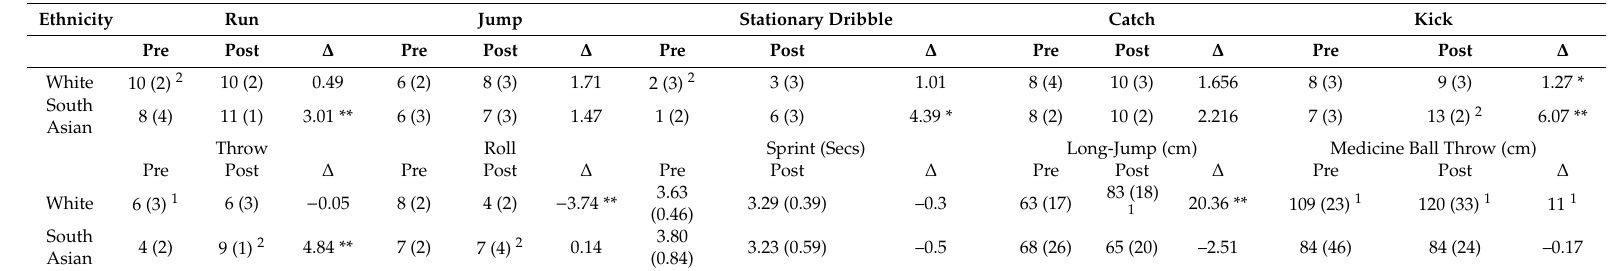
Table 4. Individual skills pre vs. post: mean